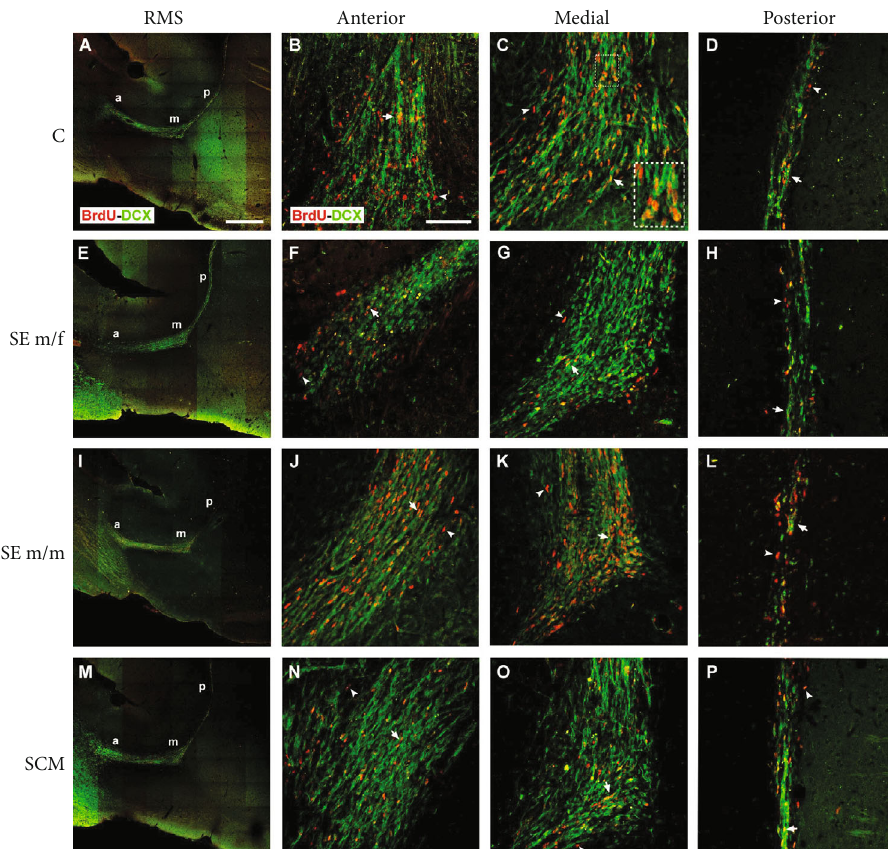
Figure 4: Representative photomicrographs of double immunolabeling for BrdU and DCX in the RMS subareas (red/green; (a, e, i, m); photomicrographs were taken at 20x, scale bar: 500 μ m). Representative photomicrographs (20x, scale bar: 100 μ m) of the anterior, medial, and posterior subareas of the RMS. Control (C; (a – d)), social exposure to a female (SE m/f; (e – h)), social exposure to a male (SE m/m; (i – l)), and social cohabitation with mating (SCM; (m – p)). A scattered square (panel C) represents enlargements of the inserts. White arrows indicate BrdU-positive/DCX-positive cells organized in chain arrangements, and arrowheads point to BrdU-positive/DCX- negative cells. a: anterior; m: medial; p: